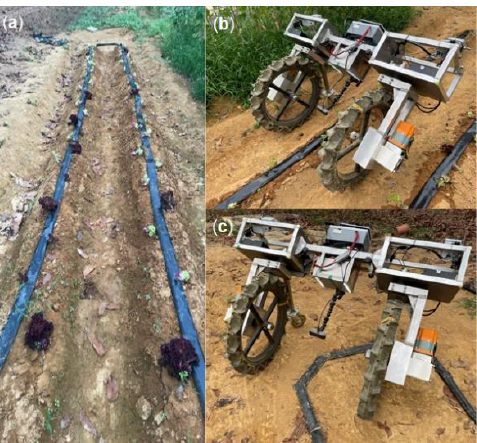
Figure 10. The appearance of experimental field and the two-wheeled robot: ( a ) the appearance of the field; ( b ) the snapshot of the two-wheeled trailer traveling autonomously; ( c ) the U-turning process of the robot trailer.